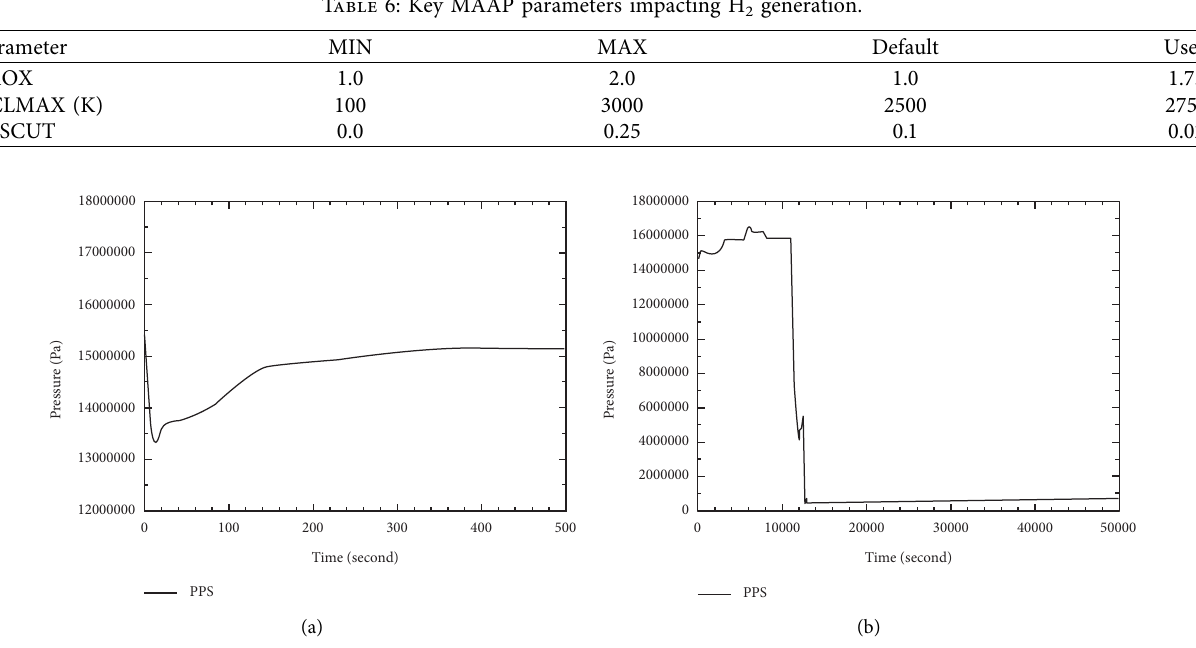
Table 6: Key MAAP parameters impacting H